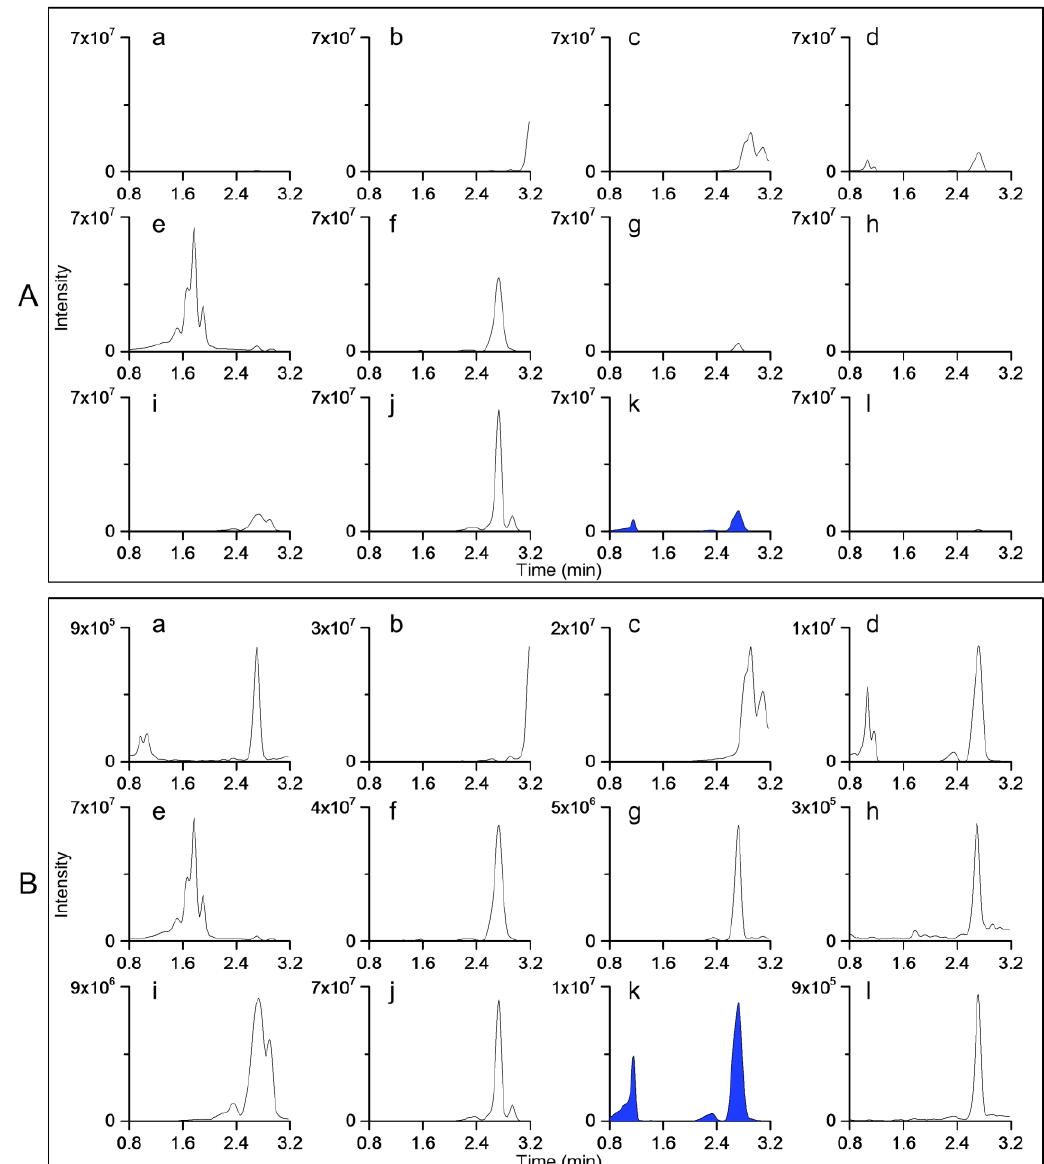
Figure 6. Fingerprints of all studied species with the species-specific method II for Syringa vulgaris . ( A ) The y-axes all samples were scaled according to the most intensive peak of all samples, which was produced by Populus tremula (e). ( B ) The y-axes were scaled to the most intensive peak of each sample. Plant species are as follows: ( a ) Acer platanoides , ( b ) Alnus glutinosa , ( c ) Alnus incana , ( d ) Fraxinus excelsior , ( e ) Populus tremula , ( f ) Prunus padus , ( g ) Quercus robur , ( h ) Salix phylicifolia , ( i ) Sorbus aucuparia , ( j ) Sorbus hybrida , ( k ) Syringa vulgaris , and ( l ) Tilia cordata . Tilia × europaea produced a similar fingerprint to that of Tilia cordata .